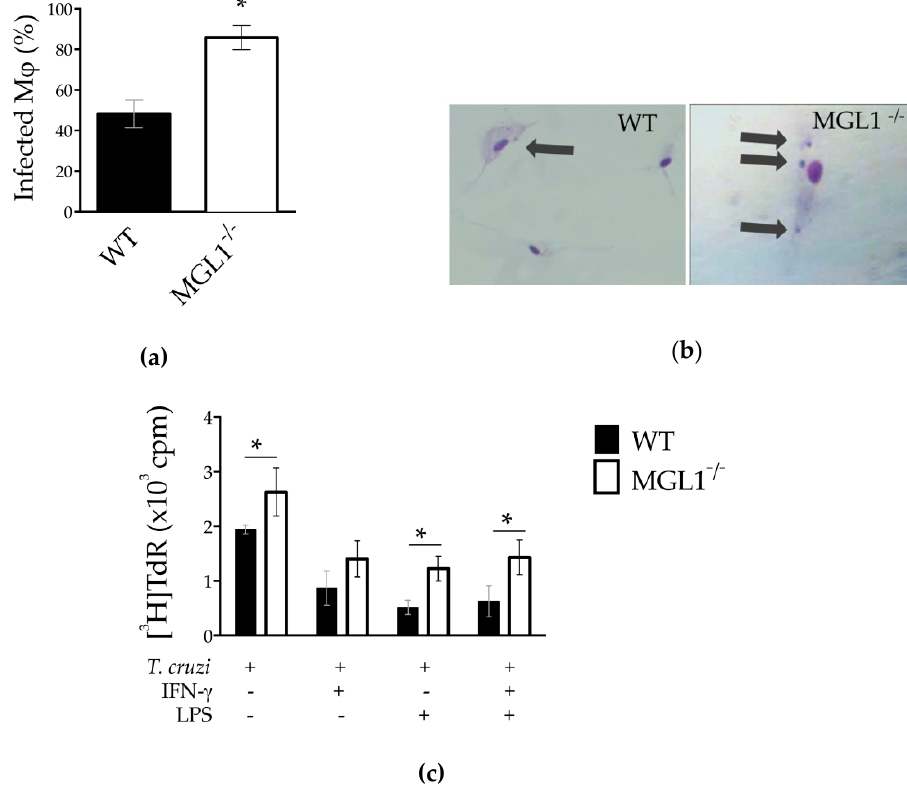
Figure 2. MGL1 − / − PE-M φ take up more T. cruzi parasites. ( a ) Percentage of PE-M φ with internal parasites in two hours after infection. ( b ) A representative image of parasites internalized in PE-M φ ; WT and MGL1 − / − PE-M φ infected with T. cruzi (arrows point to parasites), magnification 40 × . ( c ) M φ from MGL1 − / − and WT mice not treated or treated overnight with IFN- γ , LPS or IFN- γ / LPS followed by exposure to T. cruzi at a 10:1 parasite / M φ ratio. Parasites that were not taken up were removed at 2 h post-infection, and parasite infection was determined by lysis of the M φ and the measurement of parasite proliferation by [ 3 H]thymidine incorporation. The results are shown as the means of replicate samples ( ± SEM) and are representative of three experiments; * p < 0.05. Table 1. The numbers of M φ that exhibit at least one amastigote, and the number of intracellular amastigotes per M φ .